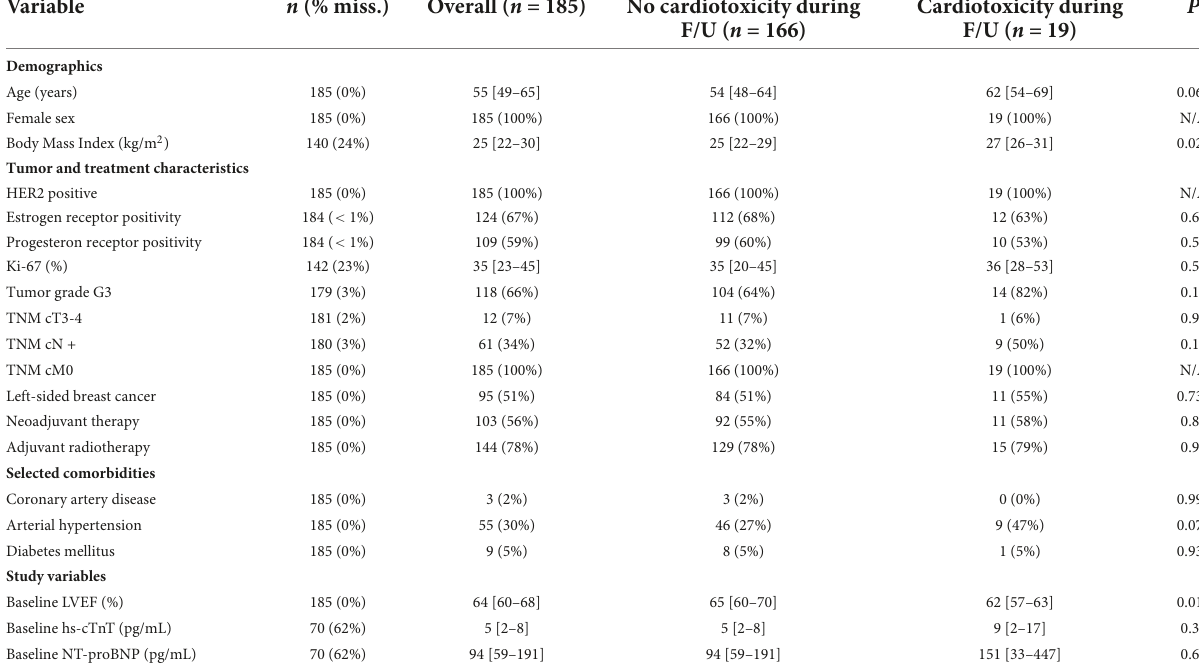
TABLE 1 Baseline characteristics of the study population ( n = 185). Variable n (% miss.) Overall ( n = 185) No cardiotoxicity during